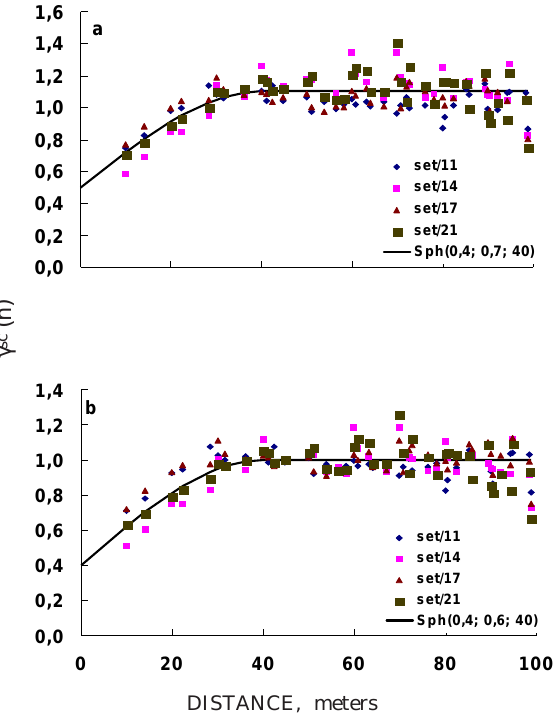
Figure 7. Scaled semivariograms for soil moisture content at 0.2 m depth for the Rideau clay loam Ottawa, Canada. a) Scaling factor equals the sill of individual semivariograms. b) Scaling factor equals the calculated variance of each property.